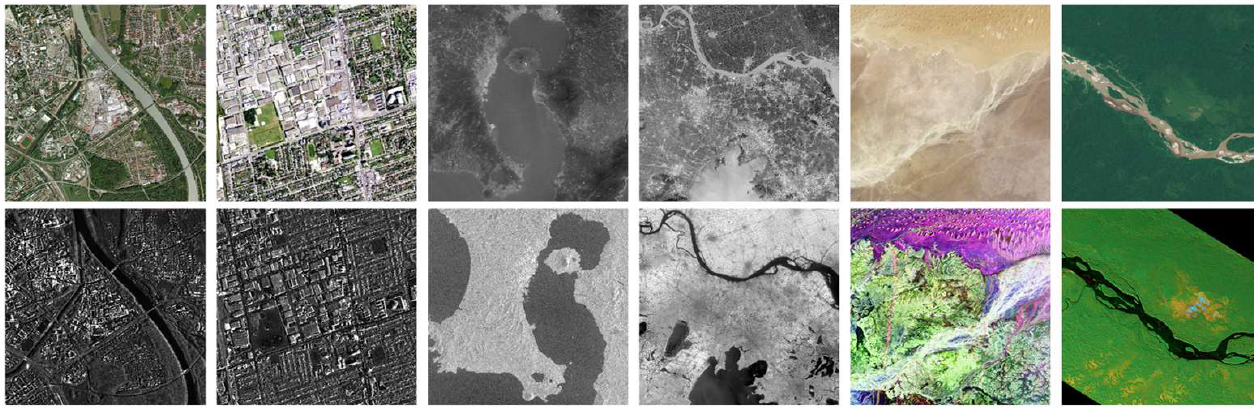
Figure 5. Six test image pairs of optical and SAR (From left to right: pairs A, B, C, D, E and F).